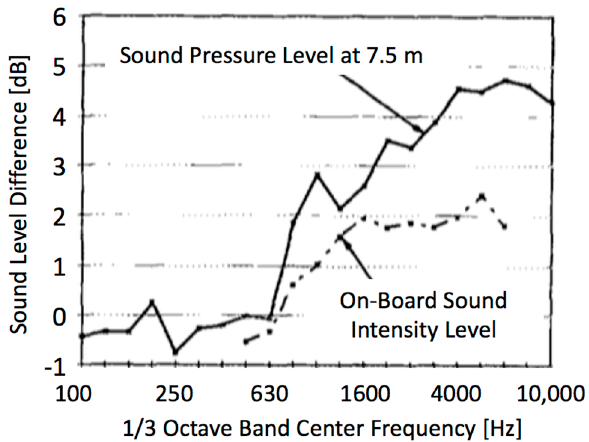
Figure 29. Difference in levels measured on ISO and SAE test surfaces (SAE less ISO) (source from Donavan et al., 1998 [39], Figure 4; reprinted with permission from AIP Publishing LLC).